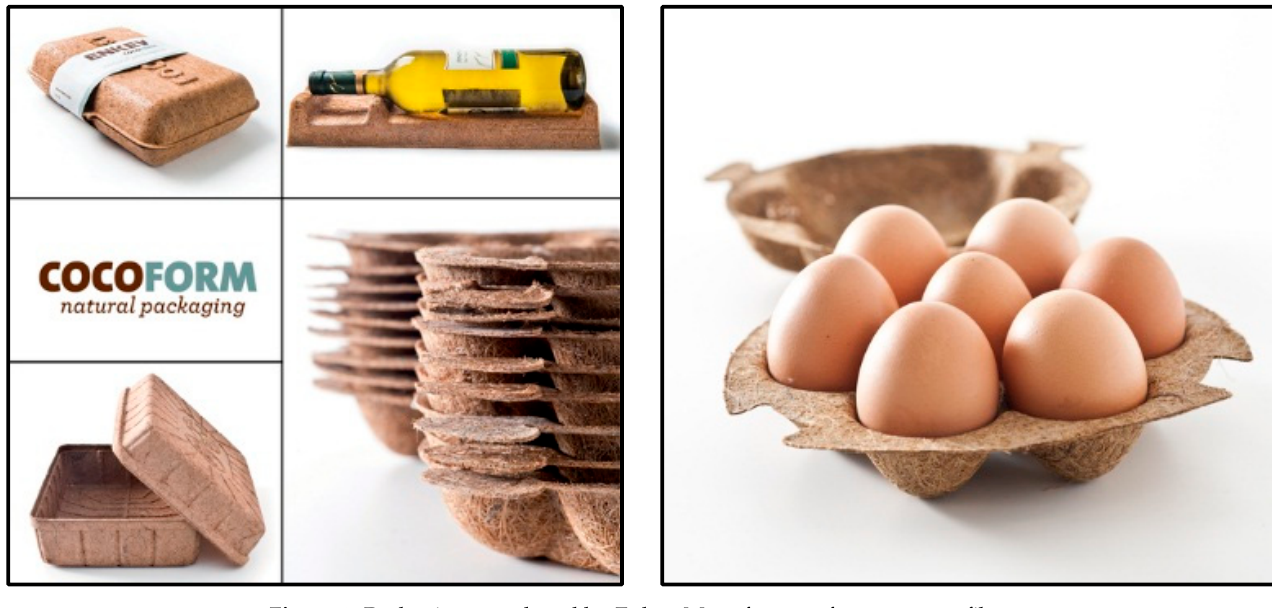
Figure 9. Packagings produced by Enkev Manufacturer from coconut fiber.